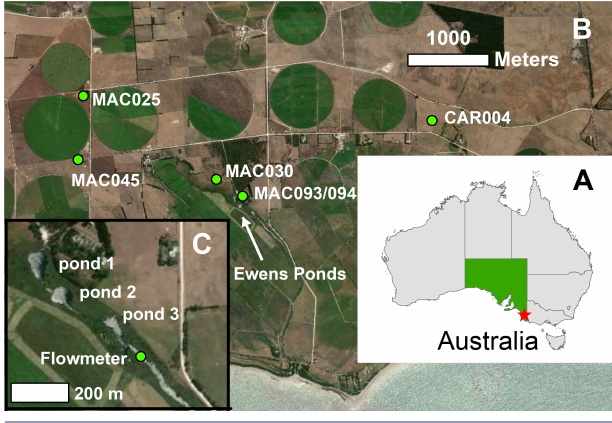
Fig. 1 . Map of study area, including (A) locations of Ewens Ponds (red star) in South Australia (shaded green); (B) location of ponds in relation to bores (MAC045, MAC093/094, MAC030, CAR004, MAC025); and (C) inset of ponds and